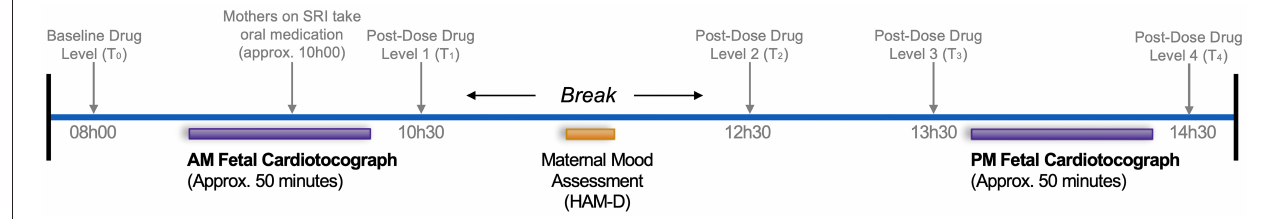
FIGURE 1 | Data collection sequence at 36-weeks’ gestation assessing pre- and post-SRI dose effects on the fetus. Text in gray pertains to SRI-treated mothers only. Times are approximate and represent the median, rounded to the nearest